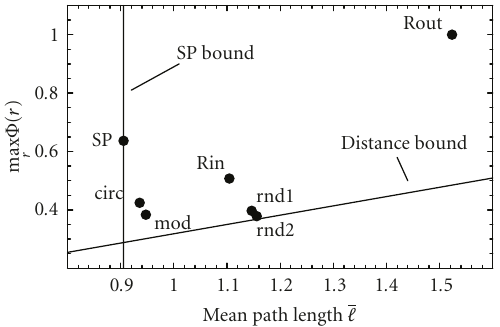
Figure 13: Comparison between the mean path length (i.e., overall forwarding load in the network) and the maximum scalar flux (i.e., tra ffi c load) for di ff erent path sets in unit disk uniform tra ffi c de- mands ( Λ =